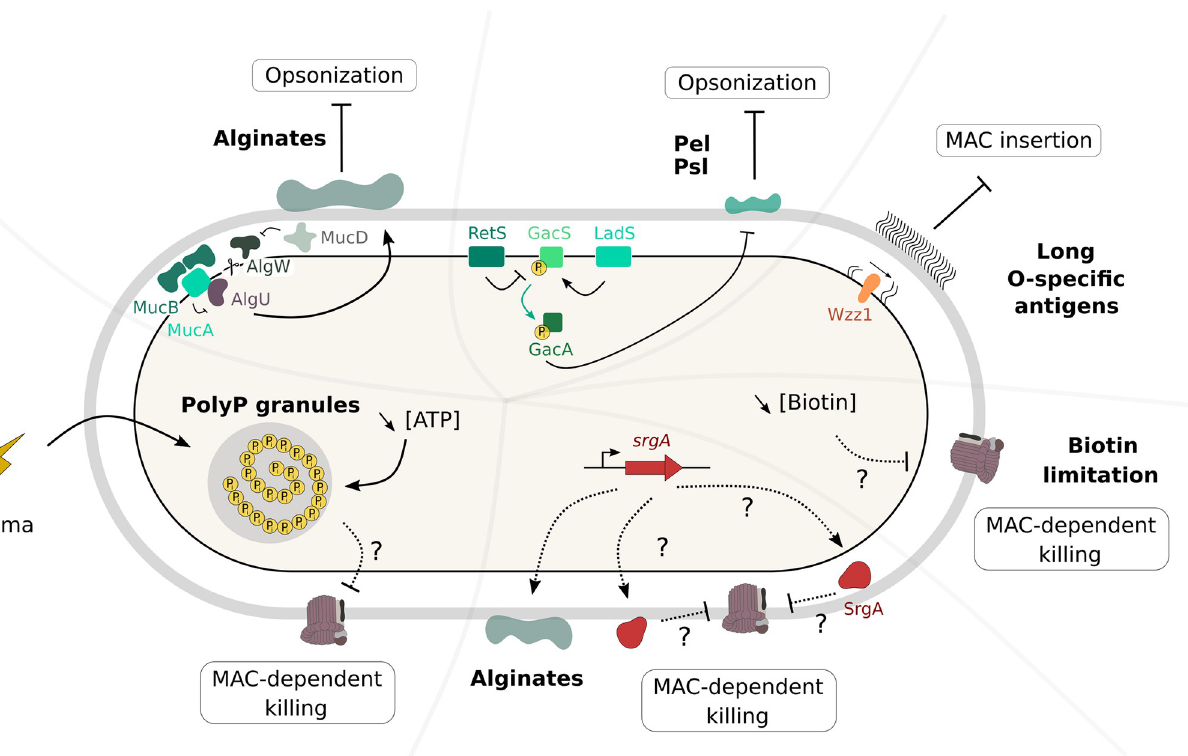
PLOS Pathogens| https://doi.org/10.1371/journal.ppat.1011023 January25,